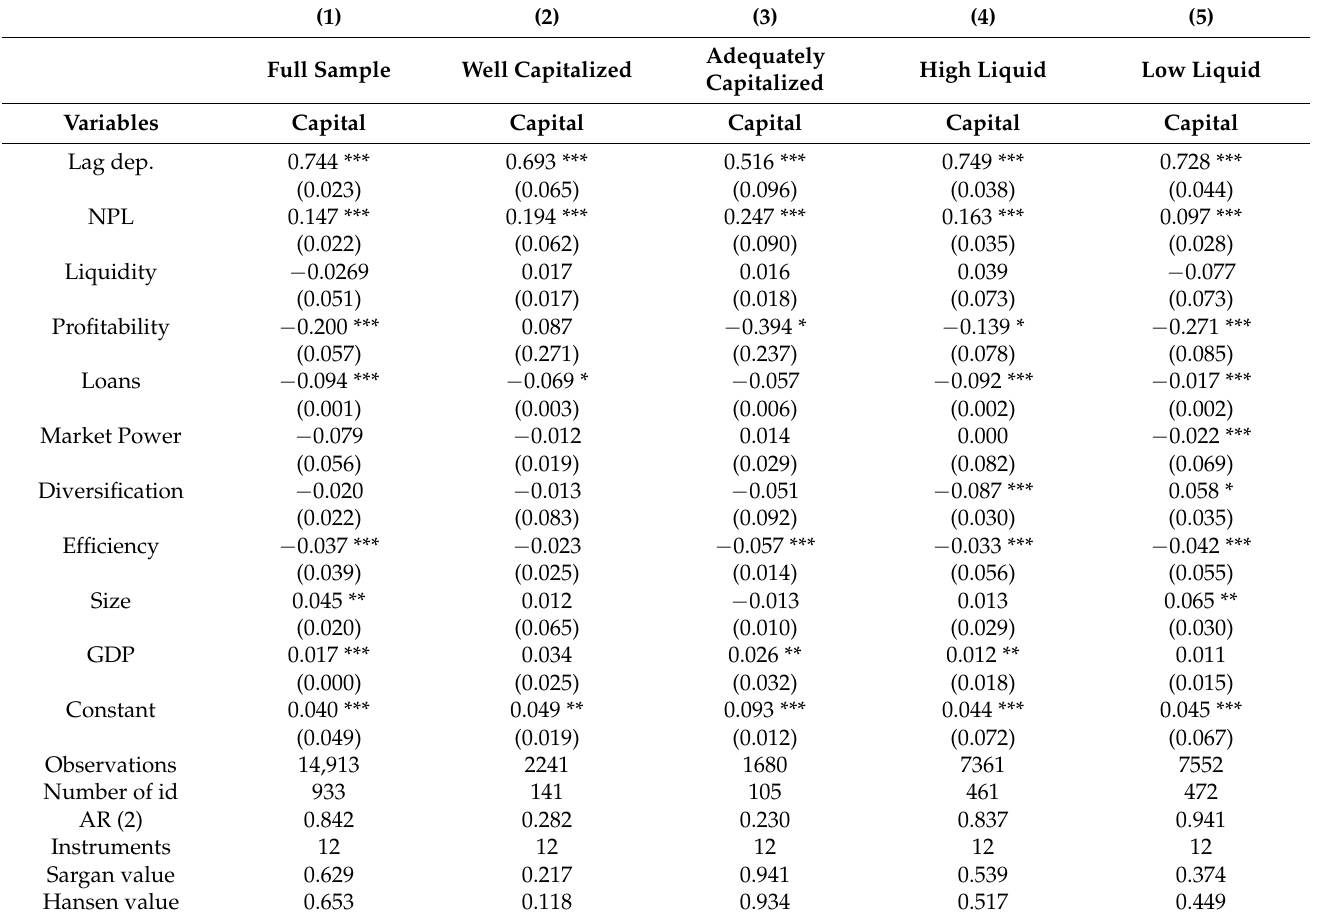
Table 4. Bank capital buffer adjustment under macroeconomic fluctuations (nominator